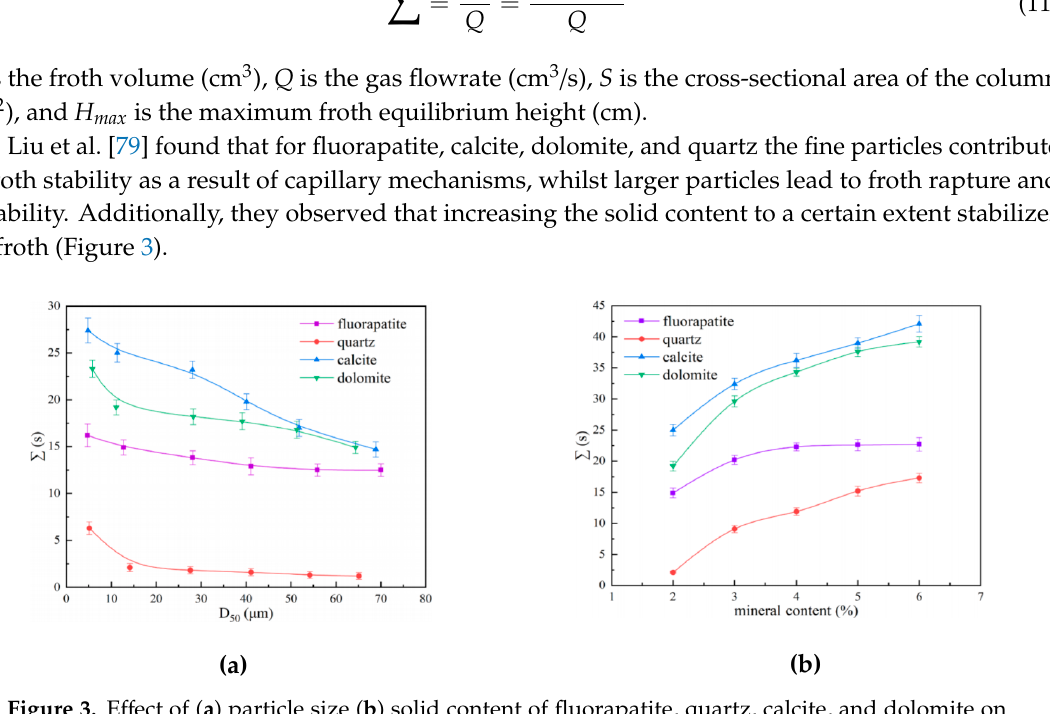
Figure 3. Effect of ( a ) particle size ( b ) solid content of fluorapatite, quartz, calcite, and dolomite on the dynamic froth stability factor [79].